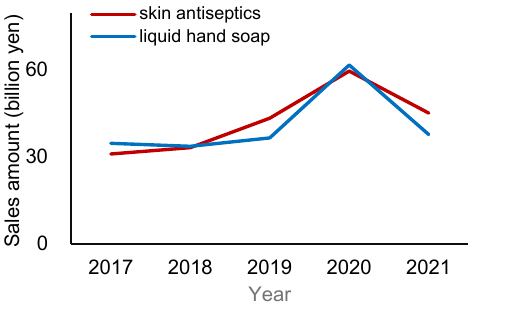
Fig. 2 Yearly sales of liquid hand soap and skin antiseptics. The data were reviewed from the open-source of the government [in Japanese]. https: // www.meti.go.jp / statistics / tyo / seidou / result / ichiran / 08_seidou.html#menu2 (liquid hand soap) https: // www.mhlw.go.jp / toukei / list / 105-1.html (skin antiseptics) (The sales amount of skin antiseptics were reviewed from the output data.)